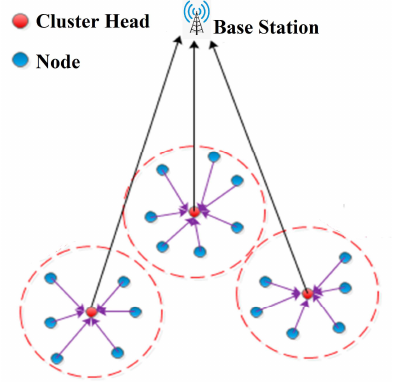
Figure 1. General architecture of a wireless sensor network.